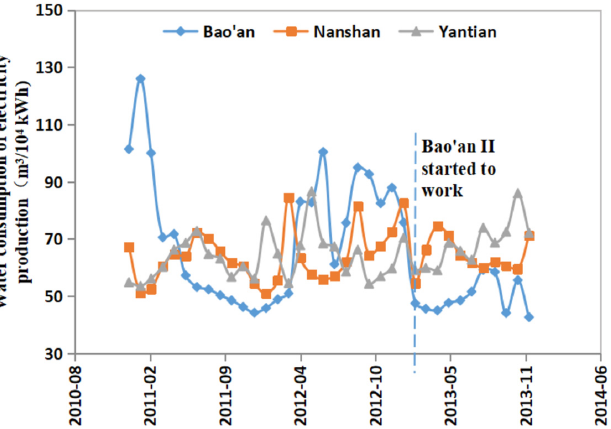
Figure 10. Cooling water use of three waste incineration power plants from January 2011 to December 2013..